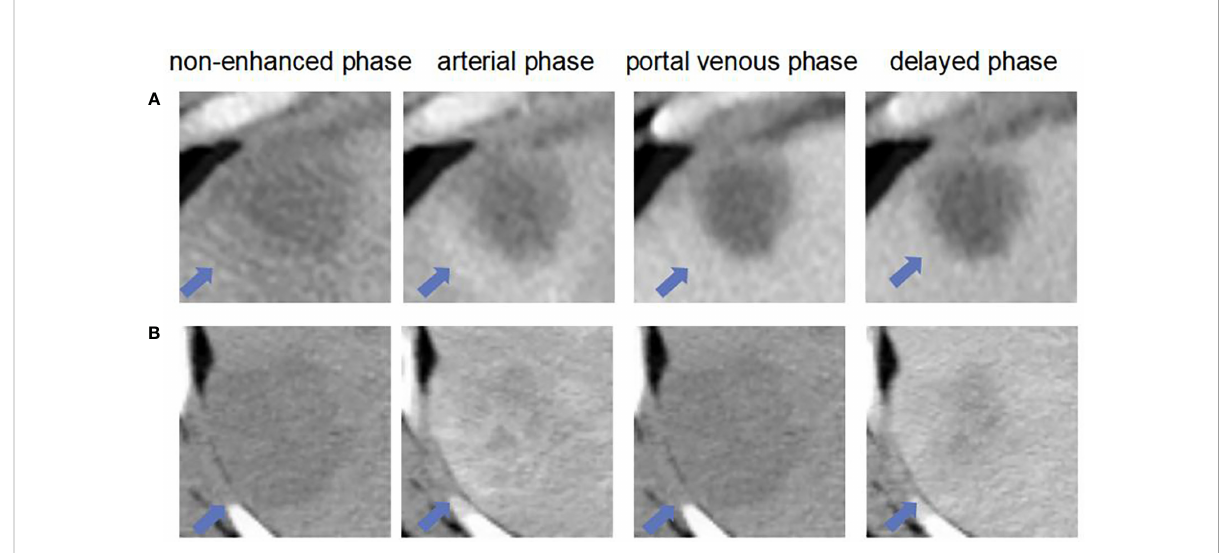
FIGURE 8 The liver masses misdiagnosed by model and two radiologists. (A) shows four phase images of a 59-year-old man with a HCC (arrow) that was diagnosed after surgery. The mass was misdiagnosed diagnosed as non-HCC by and our MExPale model and both two radiologists. (B) shows four images of a 64-year-old man with a ICC (arrow) that was diagnosed after surgery. The mass was misdiagnosed diagnosed as HCC by our MExPale model and both two radiologists.